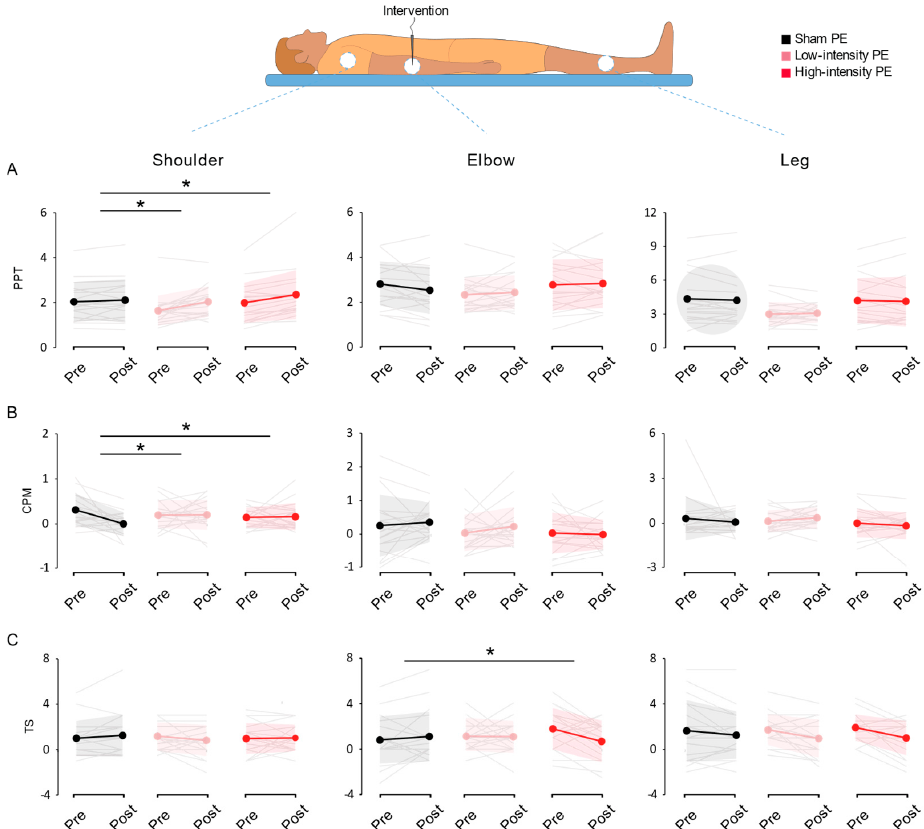
Figure 4. Pressure pain threshold ( A ), conditioned pain modulation ( B ), and temporal summation ( C ) measured in the three locations assessed. Individual data are presented as grey lines, and colored line represents mean ± SD. Asterisks indicates significations for between-group comparisons ( p < 0.05; Bonferroni post hoc test or Mann–Whitney U test).